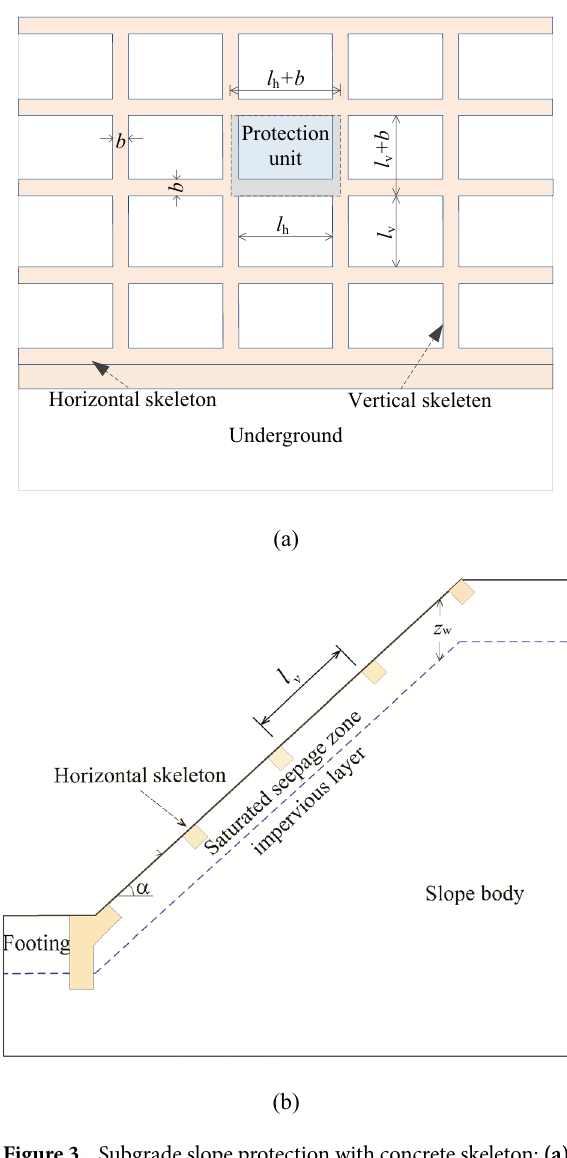
Figure 3. Subgrade slope protection with concrete skeleton: (a) plan view; (b) elevation